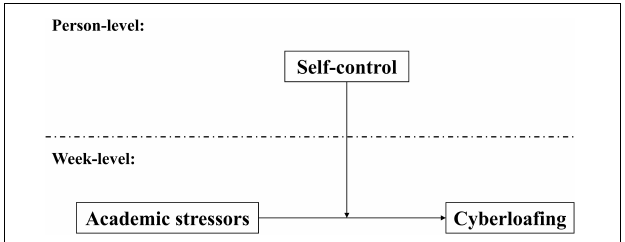
FIGURE 1 | The moderating role of trait self-control in the relationship between academic stressors and